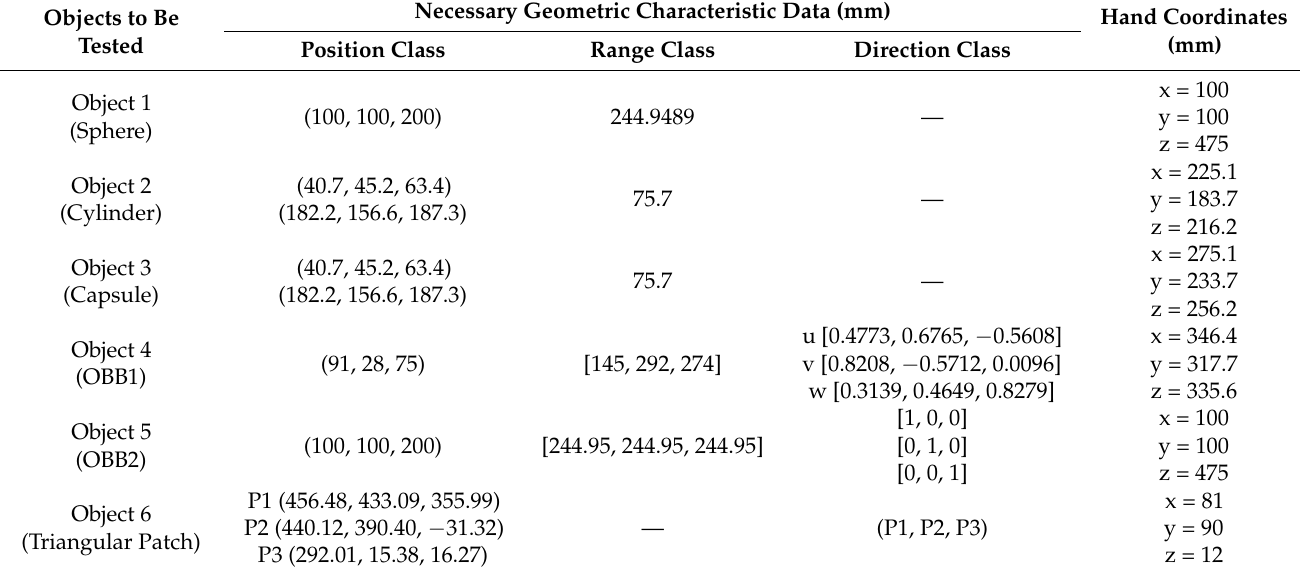
Table A1. Necessary Geometric Characteristic Data of Objects to Test the Hand